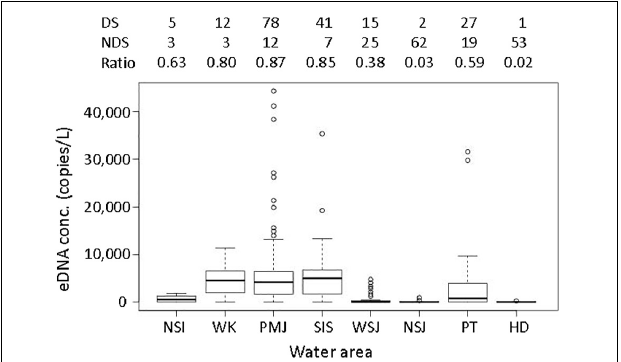
FIGURE 3 | Concentrations of environmental DNA in each region. In the box plots, the midline represents the median, the upper and lower limits of the box represent the third and first quartiles, respectively, the whiskers represent 1.5 times the interquartile range from the top (bottom) of the box to the furthest datum within that distance, and the circles represent the individual data beyond that distance. The numbers given above the graph are the number of sites where eDNA was detected (DS), was not detected (NDS), and the ratio of detected sites to the total number of sites that were sampled in each